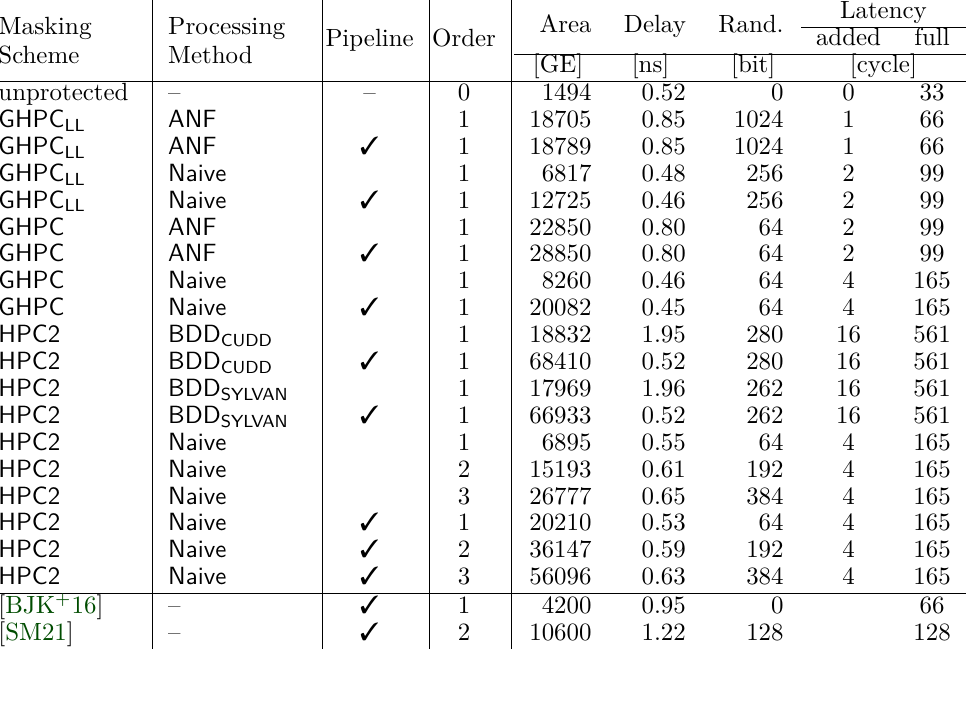
Table 11: Synthesis results, CRAFT round-based encryption